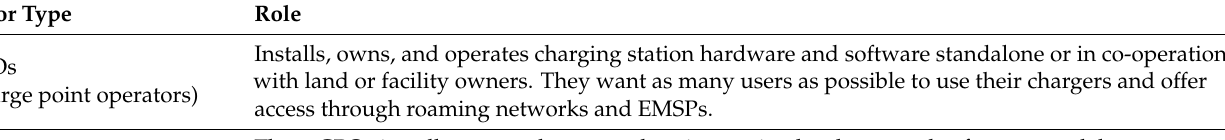
Table 1. Actor types and roles in the Norwegian charging infrastructure